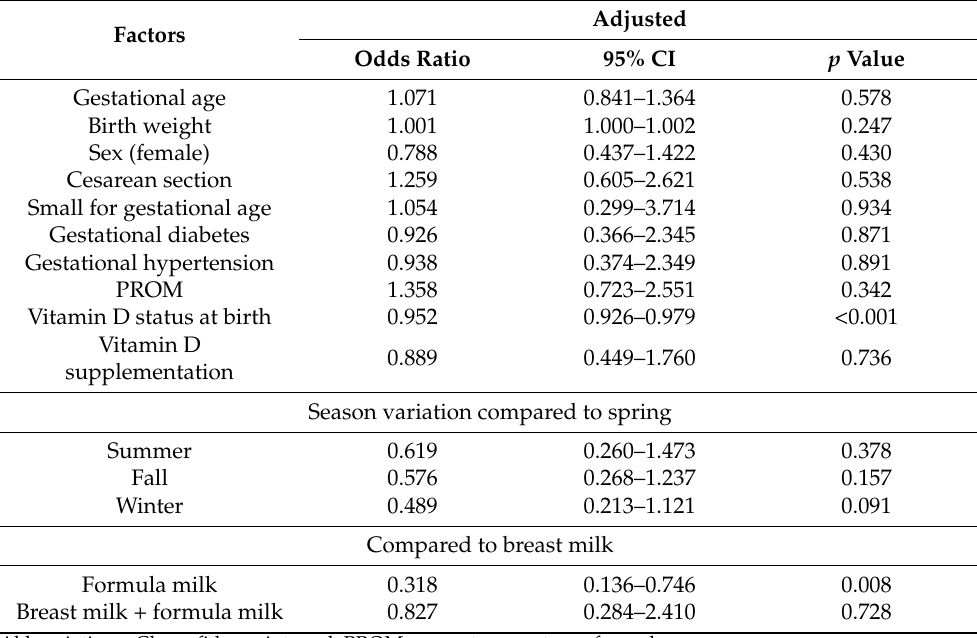
Table 4. Risk factors for vitamin D deficiency at six months after birth in preterm infants.